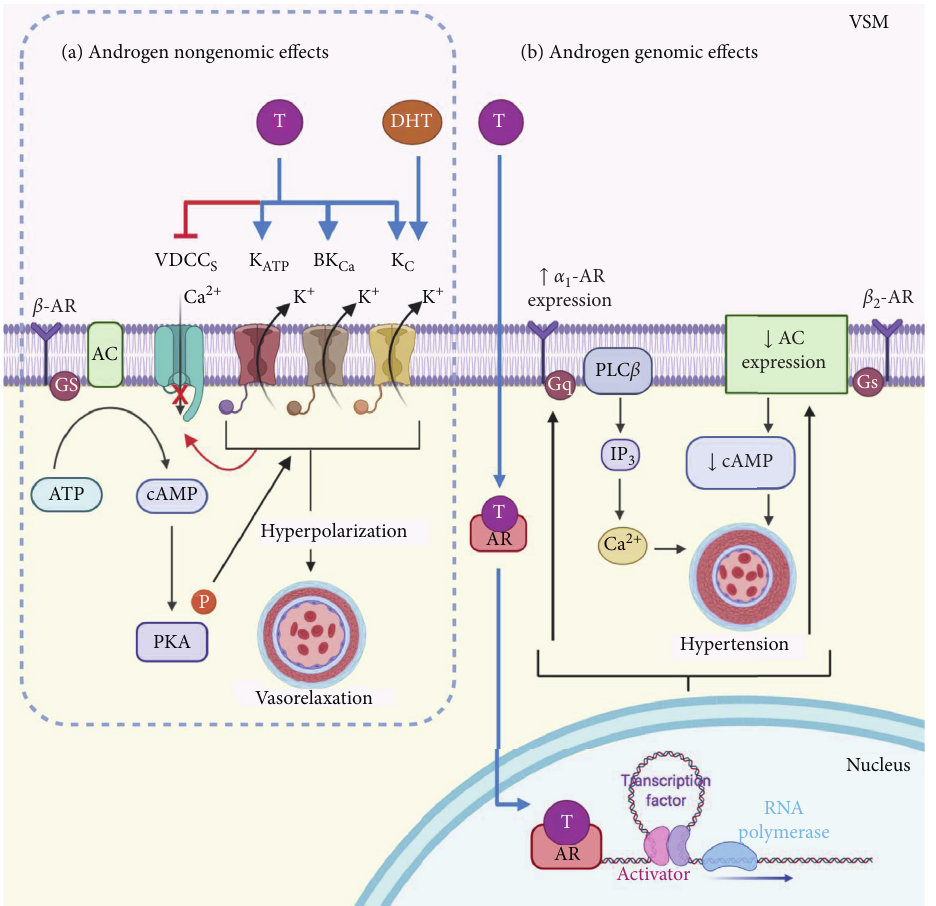
Figure 2: Androgen effects on the adrenergic system in the vascular smooth muscle (VSM). (a) Stimulation of the β -adrenergic receptor ( β -AR) leads to an increase in the activity of the K + channels and to plasma membrane hyperpolarization. β -AR receptor is coupled to a Gs protein (Gs) that activates adenylyl cyclase (AC), which enhances the synthesis of 3 ′ ,5 ′ -cyclic adenosine monophosphate (cAMP) and consequently promotes the protein kinase A- (PKA-) induced phosphorylation of the K + channels. K + channel phosphorylation increases their open probability and evokes membrane hyperpolarization that closes Ca 2+ channels, leading to vasorelaxation. Testosterone, via a rapid response (nongenomic), activates ATP-sensitive K + channels (K ATP ), Ca 2+ -activated K + channels of high conductance (BK Ca ), and voltage-dependent delayed rectifier K + channels (K V ). Dihydrotestosterone (DHT, a reduced metabolite of T) enhances the activity of the K V channel. T also blocks VDCCs. Androgen-induced vasorelaxation mediated by the activation of K + channels and the blockade of VDCCs might improve the response of β -AR signaling. (b) The genomic androgen receptor (AR) signaling involves androgen crossing the plasma membrane, entering the cytoplasm, dissociation of chaperone proteins, and binding to its cytosolic receptor. AR stimulation by T results in a decrement of AC expression and a reduction of cAMP synthesis. Moreover, Tincreases the α 1 -adrenergic receptor ( α 1 -AR) expression. This receptor is coupled to a Gq protein (Gq), which, through phospholipase C β (PLC β ), catalyzes the formation of inositol-1, 4, 5-triphosphate (IP 3 ) and triggers intracellular calcium release from the sarcoplasmic reticulum (SR). The genomic effects of Tfavor vasoconstriction in the VSM and might lead to hypertension